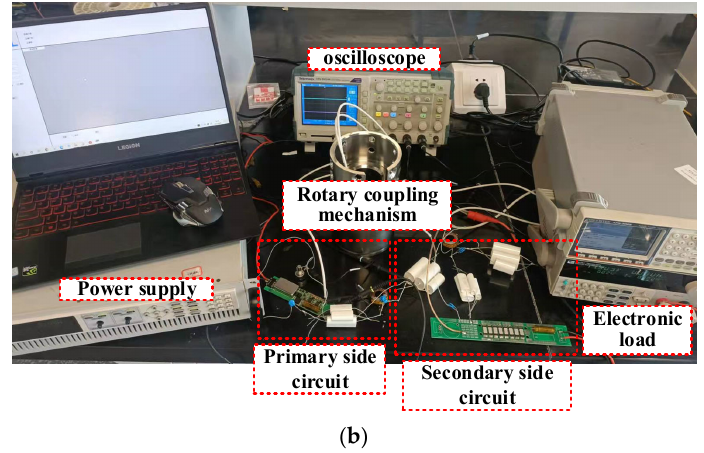
Figure 6. The laboratory prototype: ( a ) System coupling mechanism prototype; ( b ) overall system prototype.